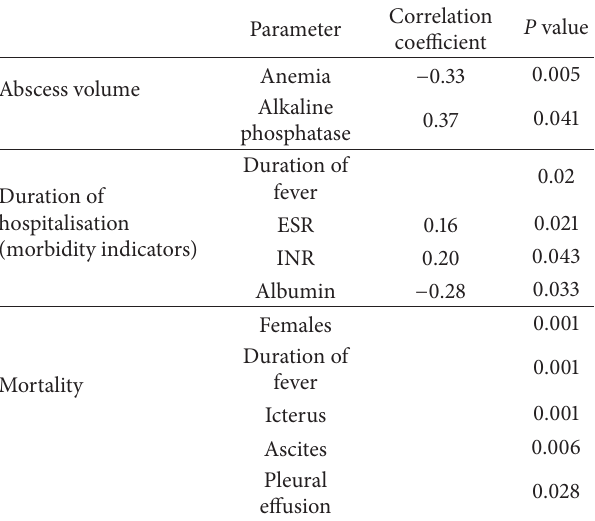
Table 6: Statistical analysis: results of statistical analysis of abscess size and duration of hospitalisation with various clinical and laboratory variables using multivariate analysis. Association of these variables with mortality was studied using Chi-square test, which has also been given (only data with significant associations has been given). Parameter